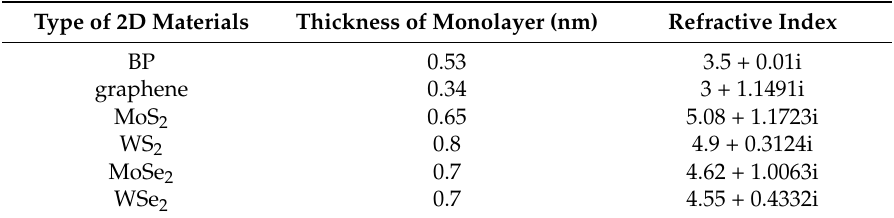
Table 1. The refractive index and thickness of different types of 2D materials at λ = 633